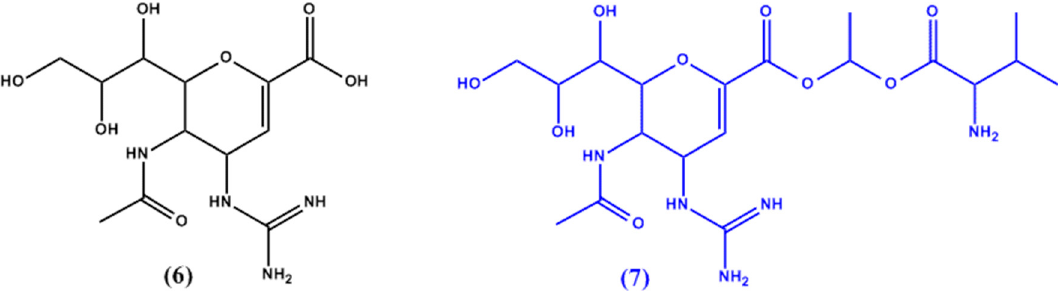
Figure 3. Chemical structures of zanamivir ( 6 ) and its valine ester prodrug ( 7 ).